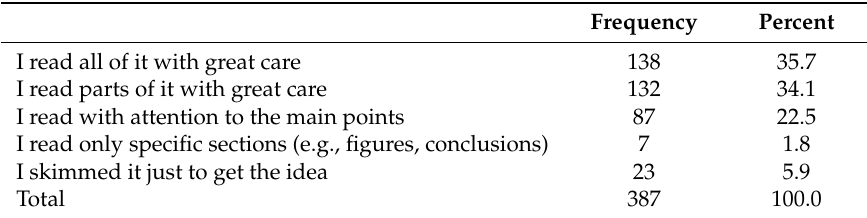
Table 9. Thoroughness of reading for last article read.